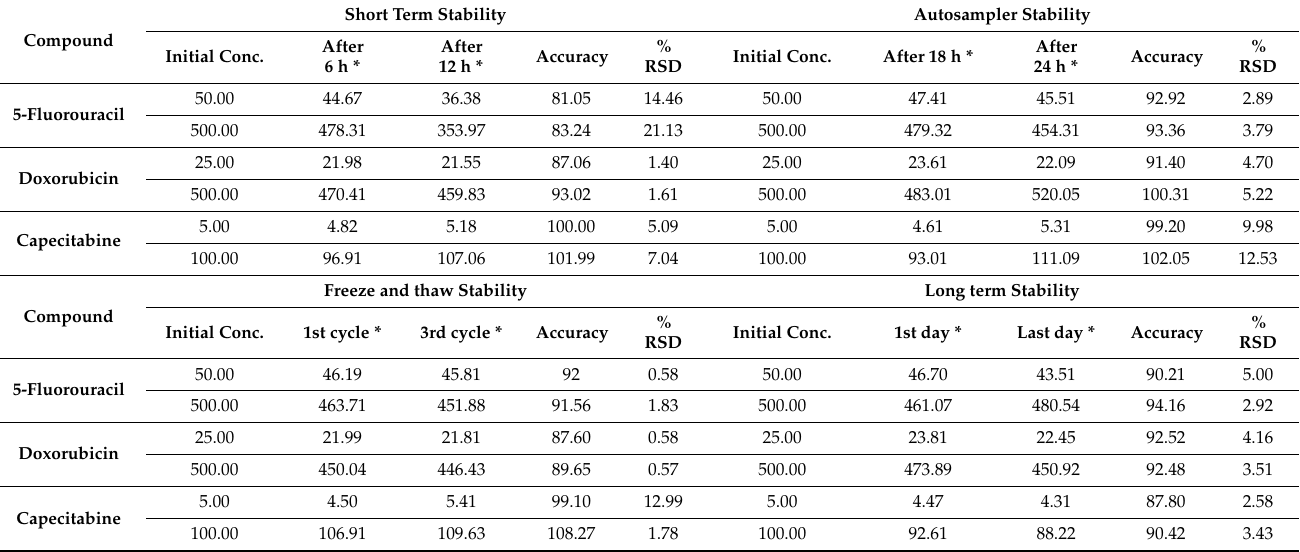
Table 4. Stability data for 5-Fluorouracil, Doxorubicin, and Capecitabine by the proposed